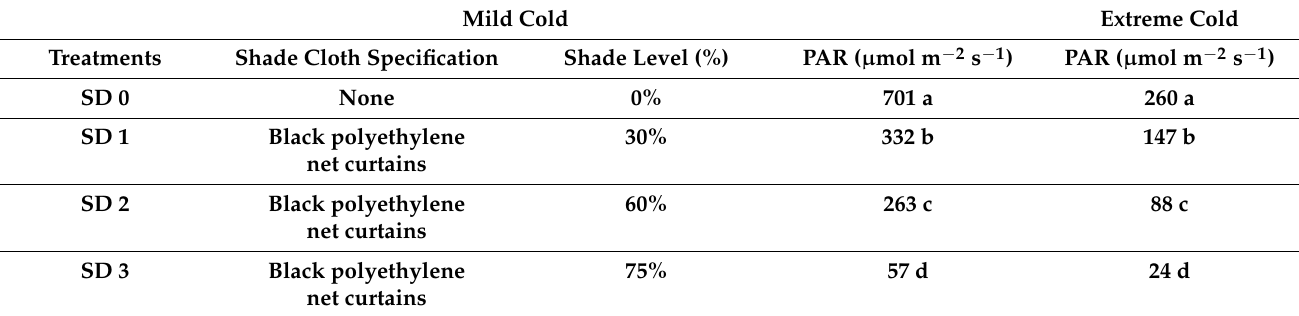
Table 1. Shade specification, measurement, and PAR before sampling at mild and extreme cold conditions.